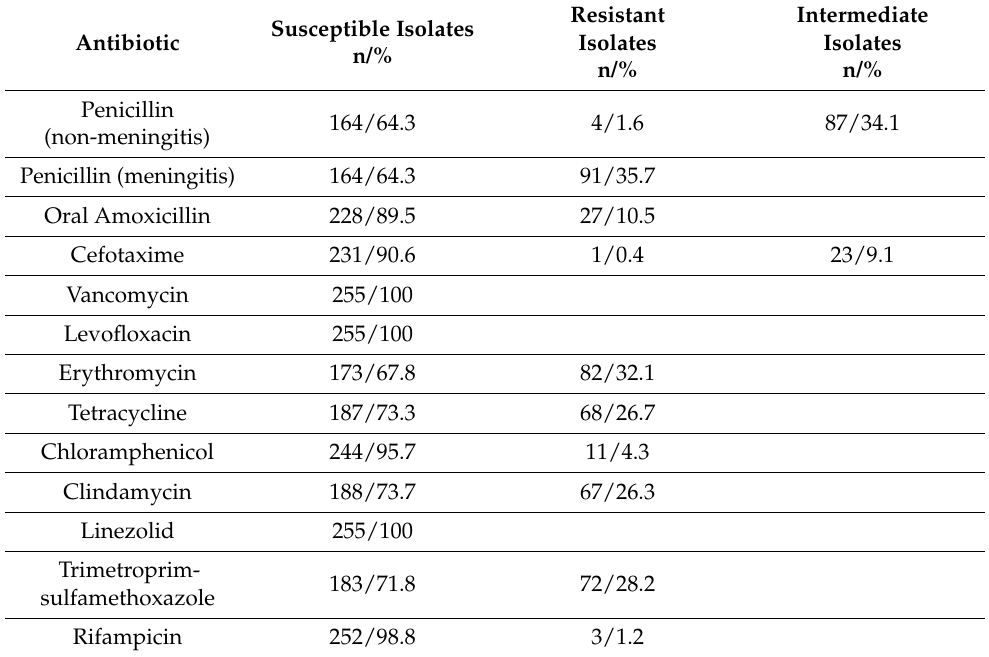
Table 3. Antimicrobial susceptibility of 255 S. pneumoniae isolates to 12 antimicrobial agents (break- points from The European Committee on Antimicrobial Susceptibility Testing (EUCAST,